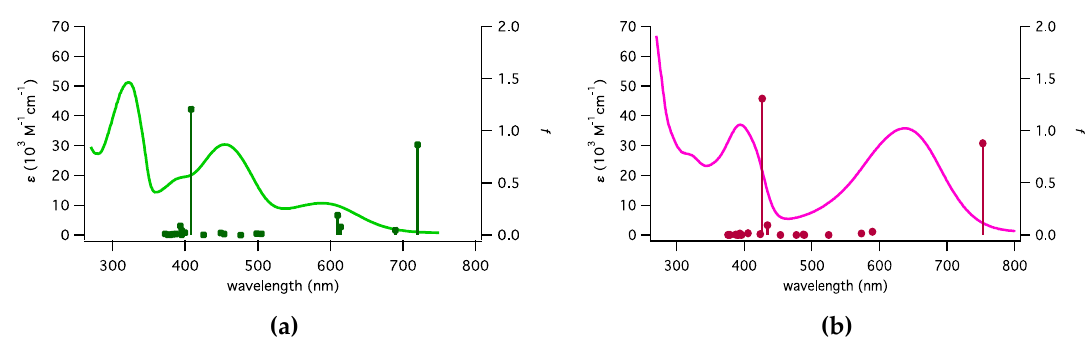
Figure 2. Linear absorption spectra (curve) of ( a ) Ru-1 and ( b ) Ru-2 in dichloromethane and the oscillator strength ( f , bar with dot) obtained from molecular orbital calculation at the B3LYP / 6-31G(d) (lanl2DZ for Ru) level in a vacuum.